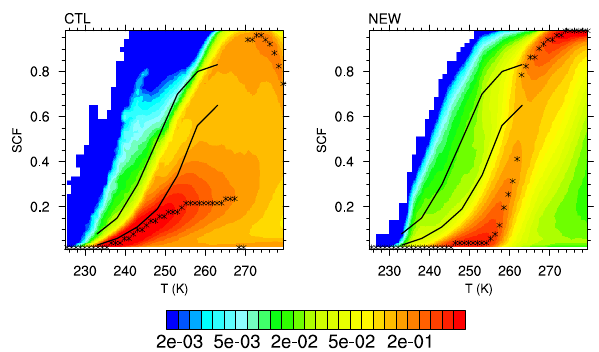
Figure 11. Global frequency of supercooled cloud fraction (SCF) from GEOS-5 for the CTL and NEW runs. The most frequent SCF value for each temperature is marked ∗ . The solid lines represent the range of SCF (mean plus and less one standard deviation) derived from the CALIOP satellite retrieval for the years 2006–2007 (Choi et al.,